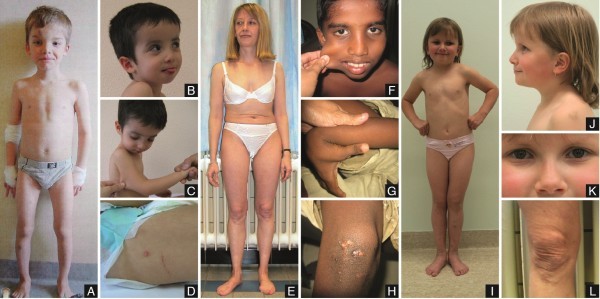
Clinical features of the probands. A: P1 at the age of 7 yrs. Note hypertelorism, several bruises on forehead and shins, mild pectus excavatum and slightly bowed legs. B-D: P2. Note the mildly blue sclerae, prominent forehead, mildly hypertrophic scarring and skin hyperextensibility. E&L: P3 at the age of 37 yrs. Note the short trunk and mildly atrophic scars on the knees. F-H: P5 at the age of 10 yrs: skin hyperextensibility, generalized joint hyperlaxity and mildly hypertrophic cicatrisation. I-K: P7 at the age of 7 yrs. She displays blue sclerae and translucent skin. Note the multiple ecchymoses and hematomas on the legs.